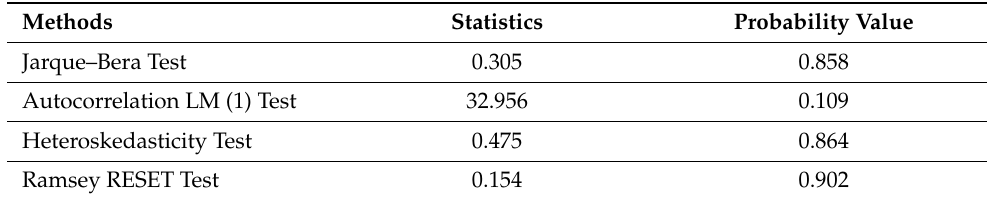
Table 7. Diagnostic Test Estimates.